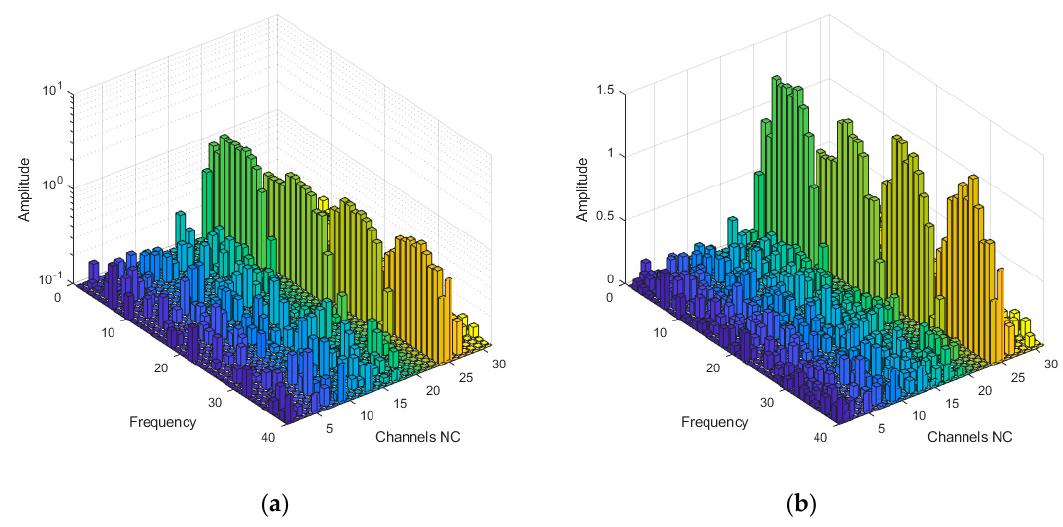
Figure 10. The magnitude response of NC channels: ( a ) Logarithmic scale; ( b ) linear scale.